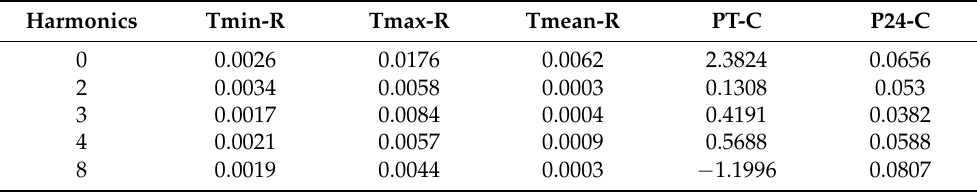
Table 6. Slope of the trend line of each series